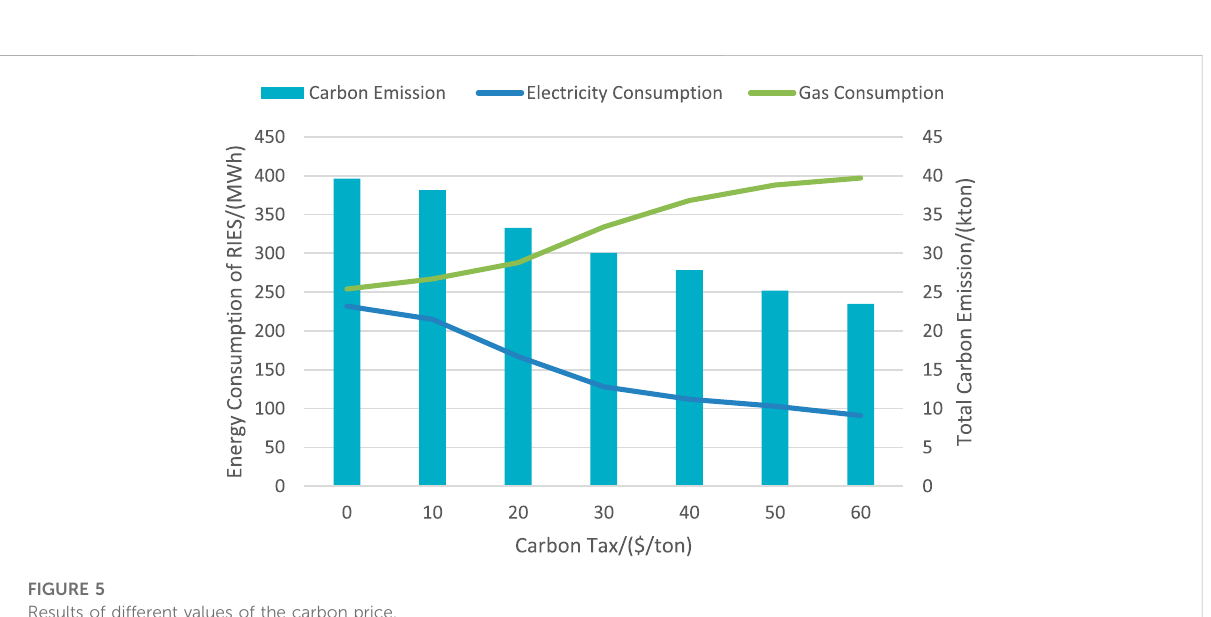
FIGURE 5 Results of different values of the carbon